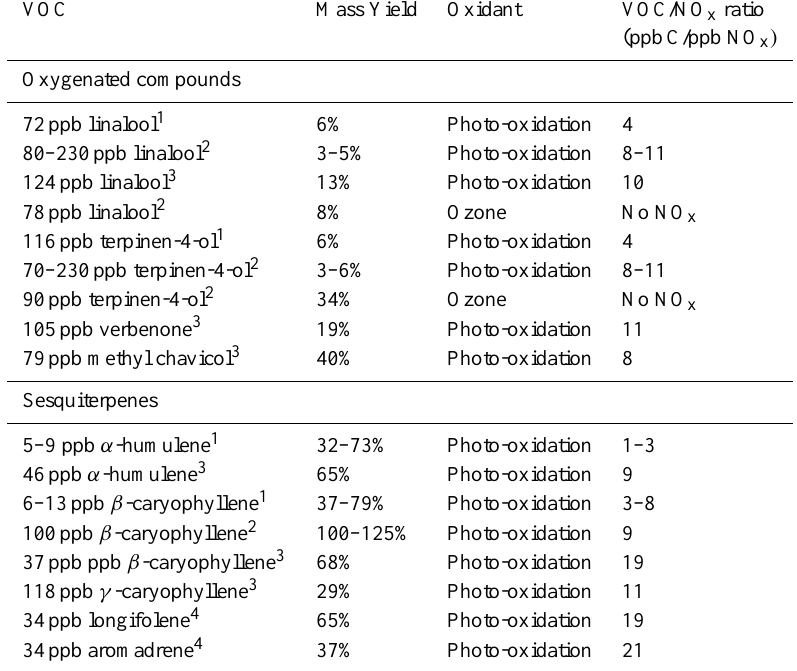
Table 2. SOA yields from VOCs in the presence of NO x . VOC Mass Yield